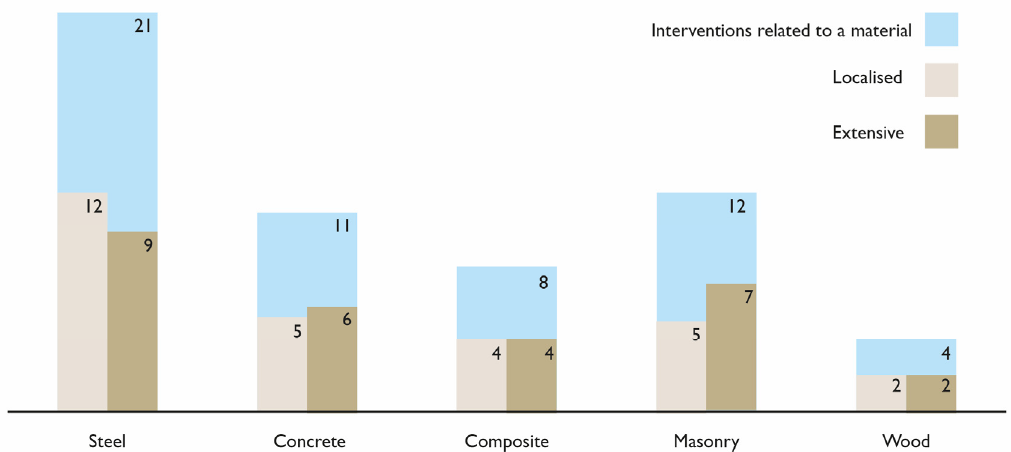
Figure 4. Interventions classified based on the main material and type (localised and extensive). Table 7. Qualitative indicators for seismic retrofitting.